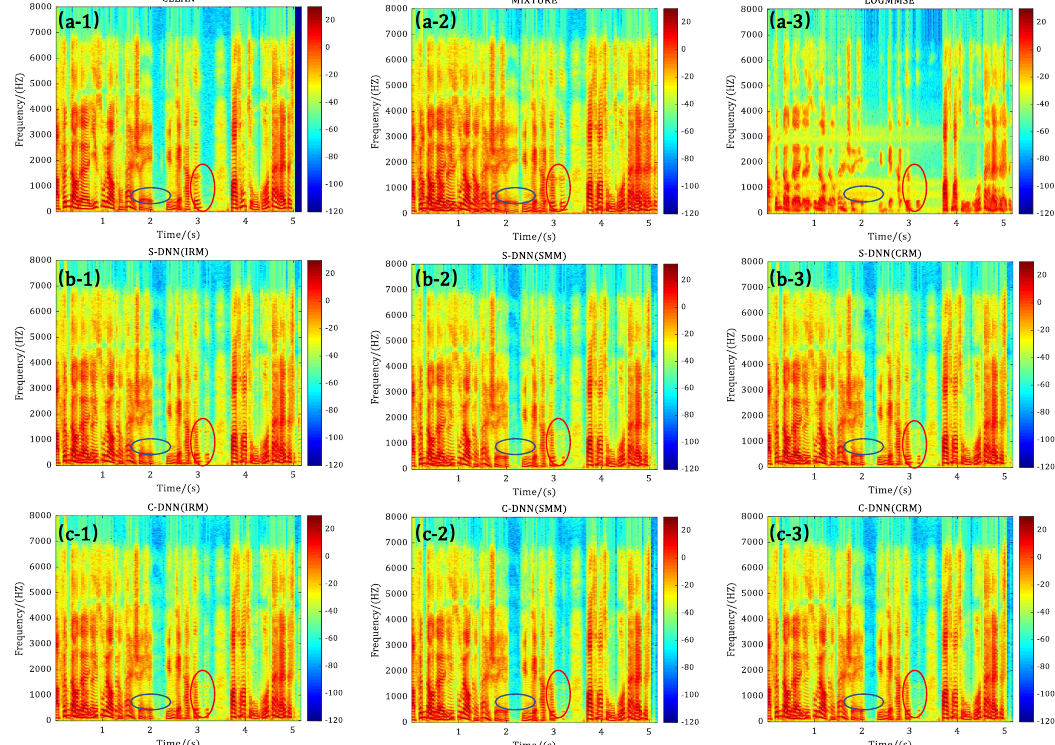
Figure 7. Spectrograms of test data No. 496 obtained by various methods. LOG-MMSE is reproduced based on [7], S-DNN(IRM) and S-DNN(CRM) corresponding to [20,26], respectively. For C-DNNs, the results obtained using three training targets IRM, SMM, and CRM are provided for comparison. ( a-1 ) clean signal. ( a-2 ) noisy signal. ( a-3 ) processed by LOG-MMSE. ( b-1 ) to ( b-3 ) processed by S-DNN with IRM, SMM and CRM target, respectively. ( c-1 ) to ( c-3 ) processed by C-DNNs with IRM, SMM and CRM target,